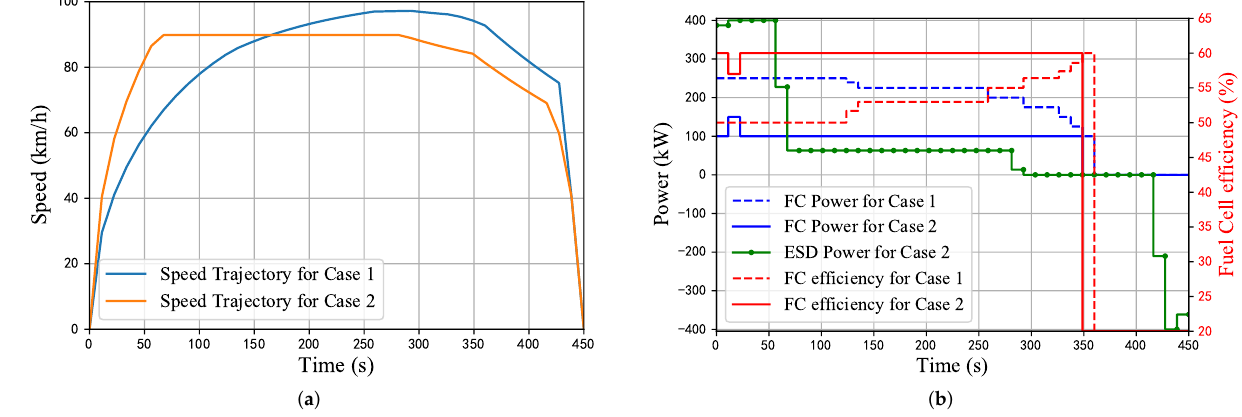
Figure 6. ( a ) Optimized speed trajectory using the co-optimization model for Case 1 and Case 2. In Case 1, with no ESD deployed and lower maximum traction power, the acceleration phase is prolonged from around 85 s to around 250 s. ( b ) Power splits between fuel cell and ESD, and the fuel cell efficiency. In Case 2, the train obtains the higher traction power which is the sum of fuel cell output power and ESD output power. The train in Case 1 has higher fuel cell power since there is no ESD to provide extra power. Compared with the fuel cell in Case 1, its counterpart in Case 2 works at a higher efficiency in general, as can be seen by looking at the red solid line and dashed